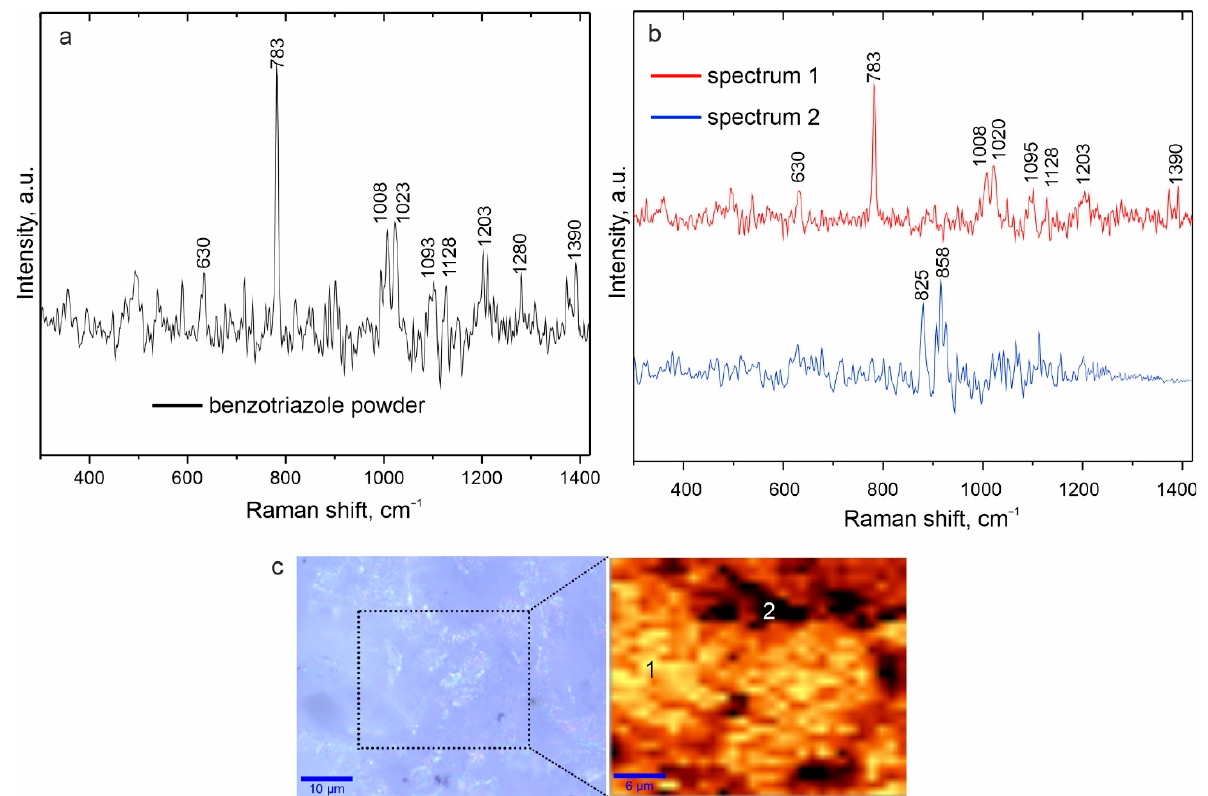
Figure 5. Raman spectrum of benzotriazole powder ( a ), Raman spectra collected in the areas (marked with numbers 1 and 2 in ( c )) of the sample coated with CC-0.1 ( b ), optical image and 2D inhibitor distribution map ( c ).